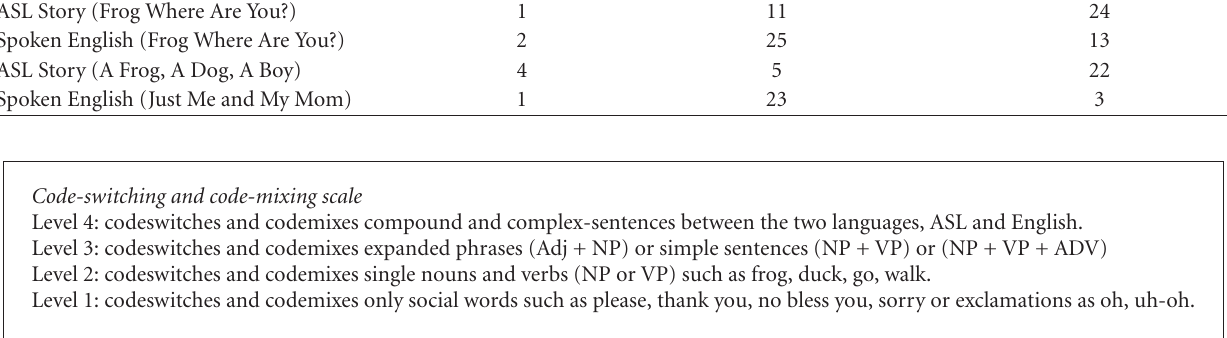
Table 1: Summary of Language Use by Alice in Four wordless book storybook retellings.